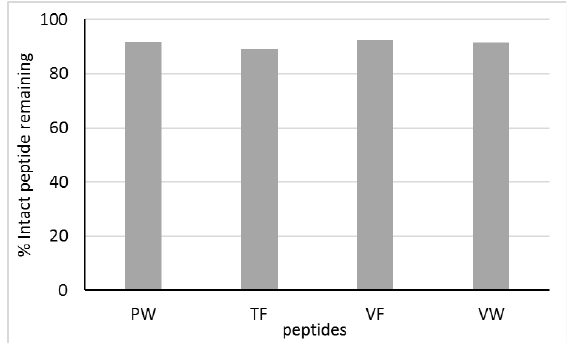
Figure 5. The percentage of peptides remaining intact after 2 h Caco-2 cell absorption. Each bar represents the mean and standard deviation of three replicates.